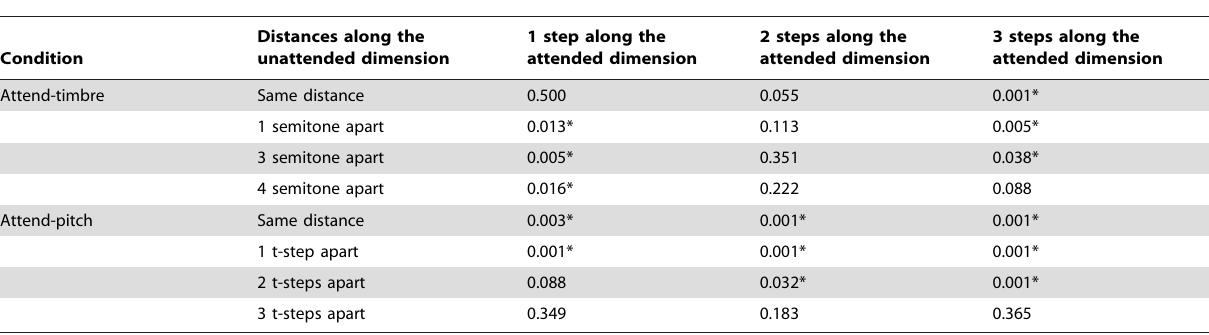
Table 2. Lilliefors normality test p-values for the d’ scores in all conditions.